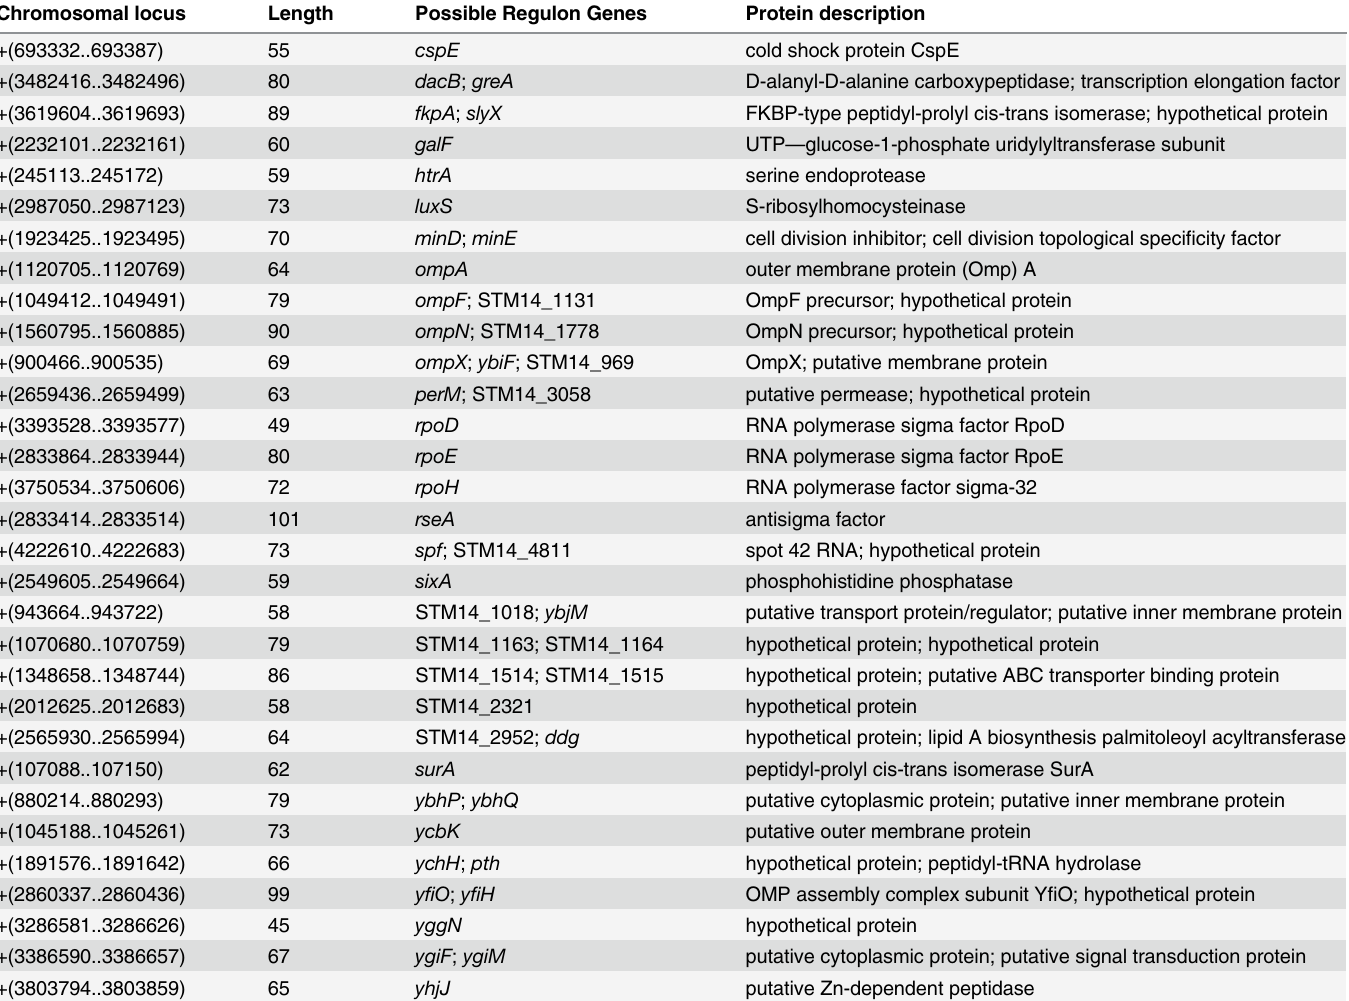
Table 1. σ E ChIP peak-associated genes. Chromosomal